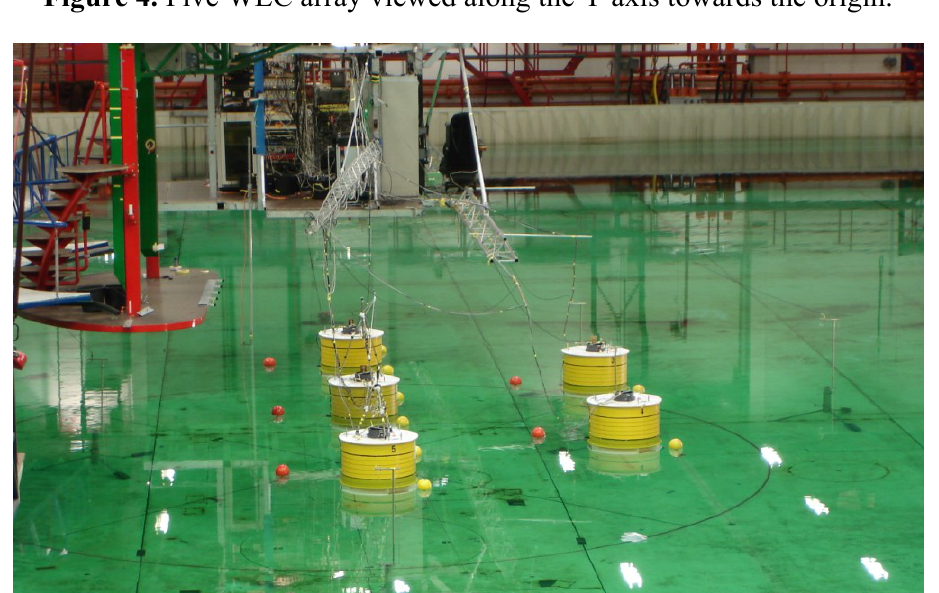
Figure 4. Five WEC array viewed along the Y axis towards the